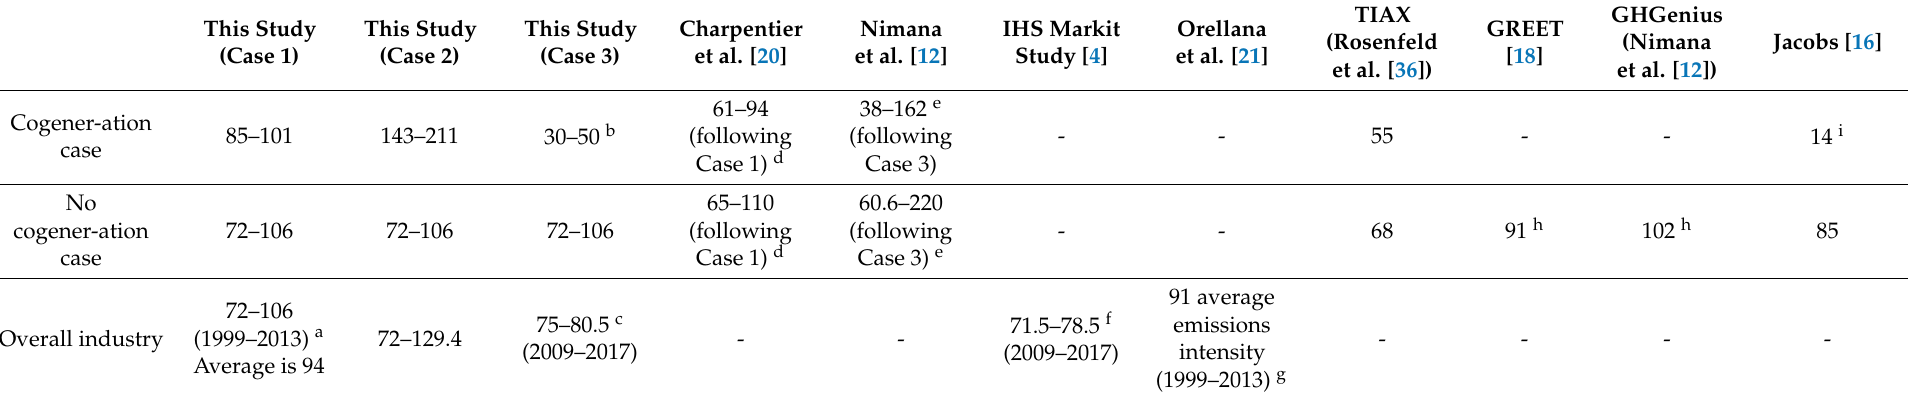
Table 1. Comparison of this study’s results with those of previous